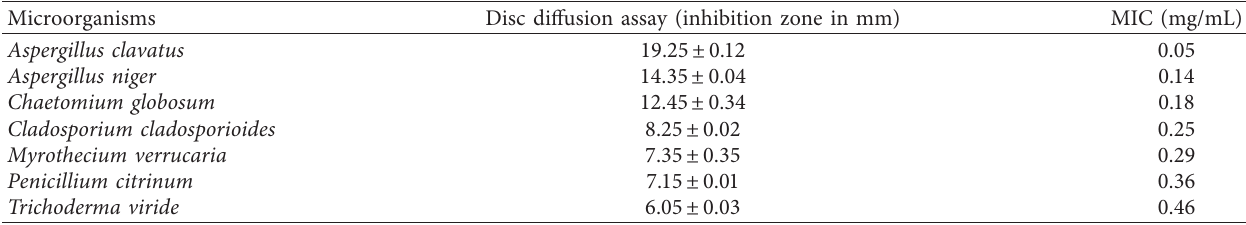
Table 2: Minimum inhibitory concentration (MIC) of essential oil from L. nobilis flowers (mg/mL).